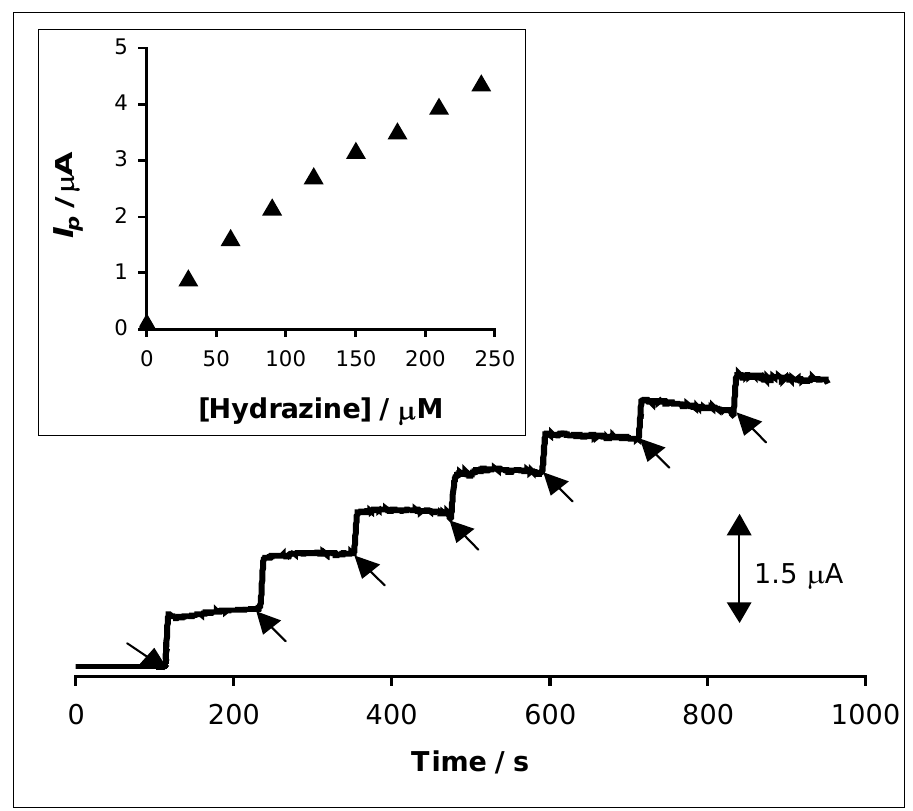
on successive additions of 30 4